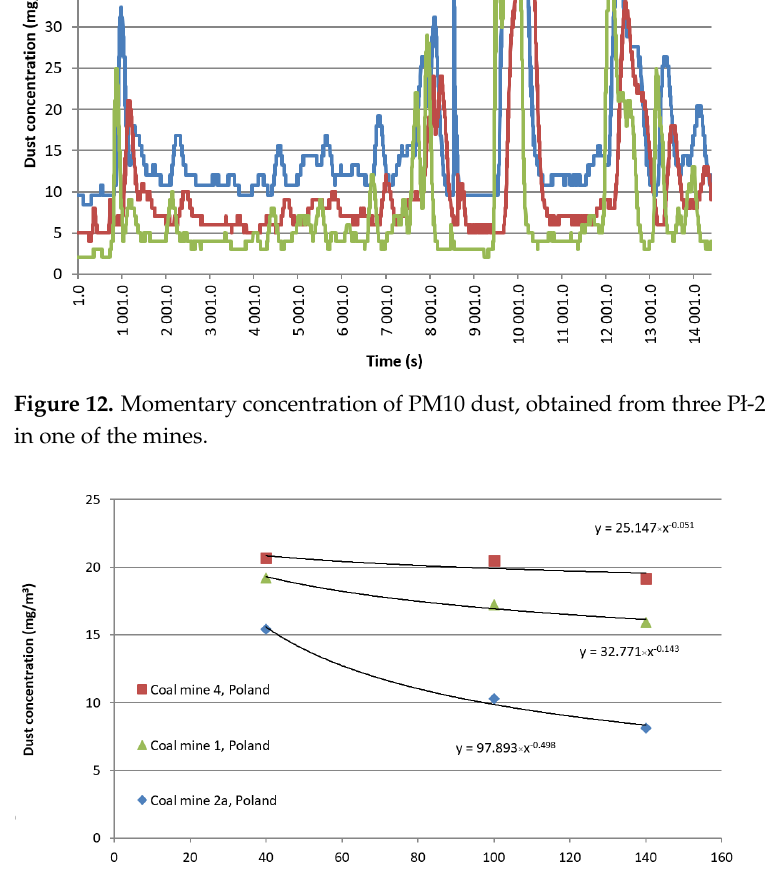
Figure 13. Characteristics of the average distribution of PM10 dust concentration depending on the distance in the coal faces, based on the results from P ł -2 dust meters with the functions that describe them.